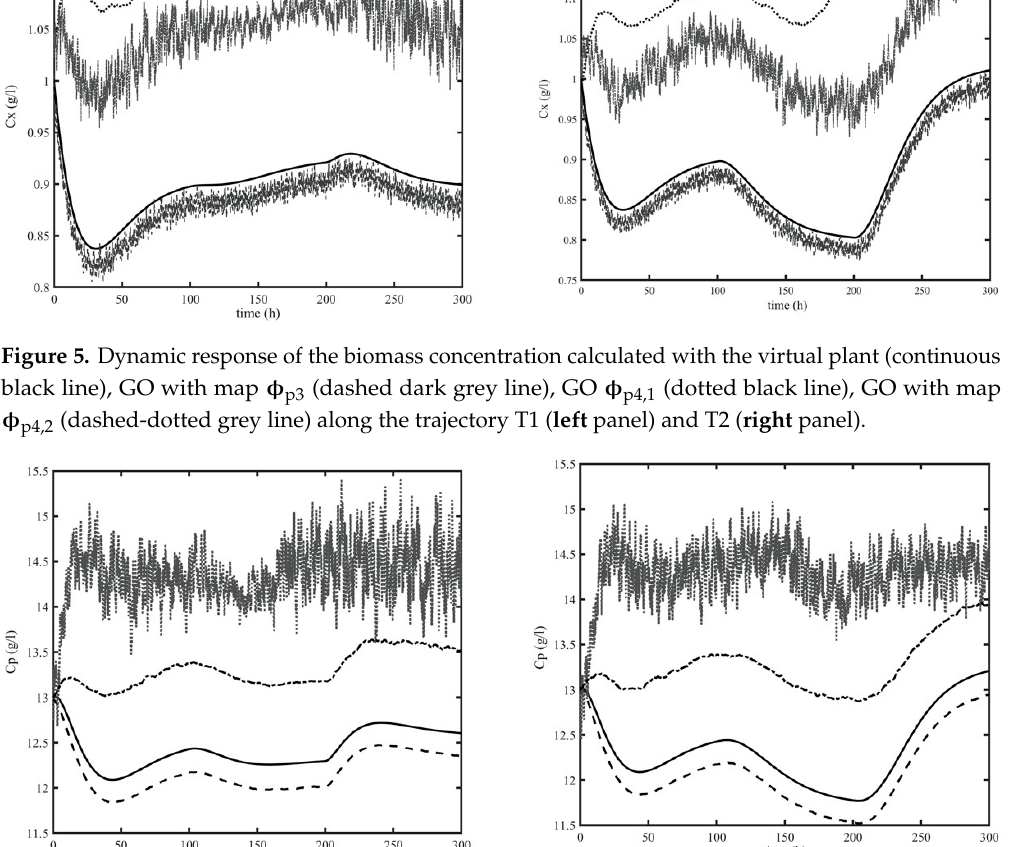
Figure 6. Dynamic response of the product concentration calculated with the virtual plant (continuous line), GO with map φ p3 (dashed black line), GO with map φ p4,1 (dotted black line), GO with map φ p4,2 (dashed-dotted grey line) along trajectory T1 ( left panel) and T2 ( right panel).